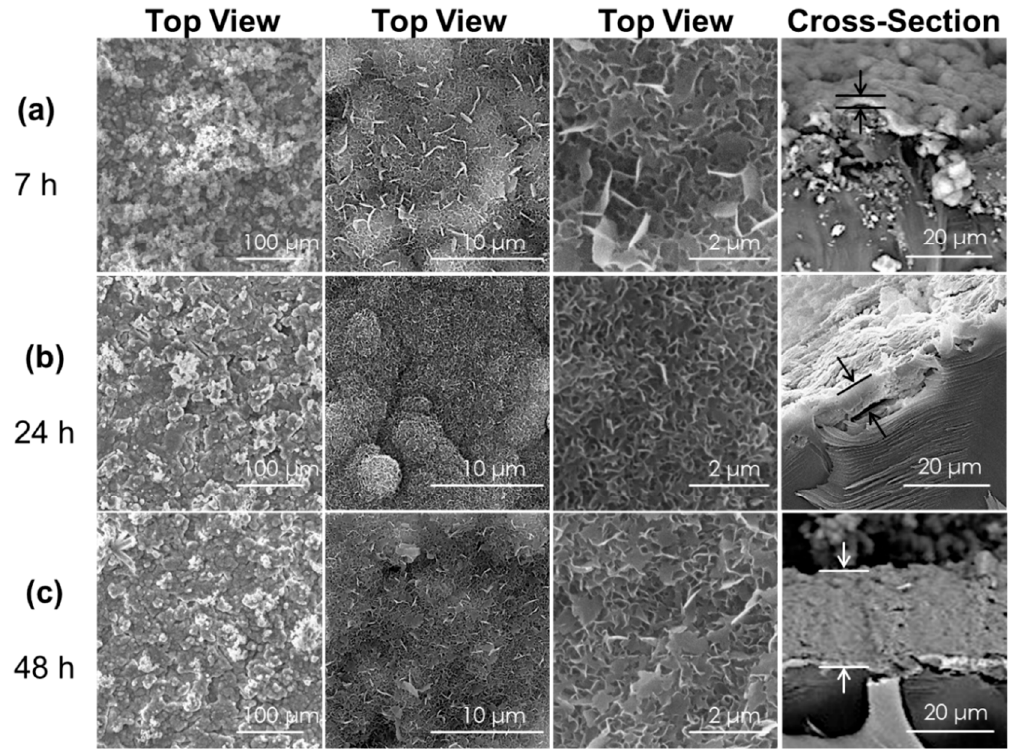
Figure 2. Scanning electron microscopy images of the top surface morphology and cross-section of bCaP coating before PEM and before cell culture. Times shown on right column are lengths of time in the simulated body fluid solution. ( a ) bCaP (7 h) thickness = 1.8 ± 0.7 µ m; ( b ) bCaP (24 h) thickness = 5.8 ± 1.8 µ m; and ( c ) bCaP (48 h) thickness = 24.0 ± 2.4 µ m.